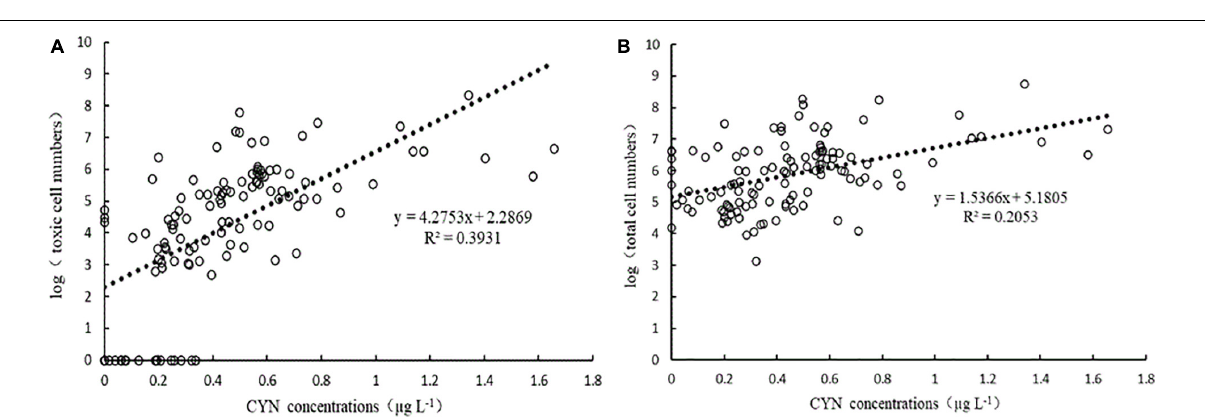
( Supplementary Figures 2, 3 ). The chl-a concentration curves of four R. raciborskii strains in N1 and P1 treatments were not significantly different from those in the control ( P >